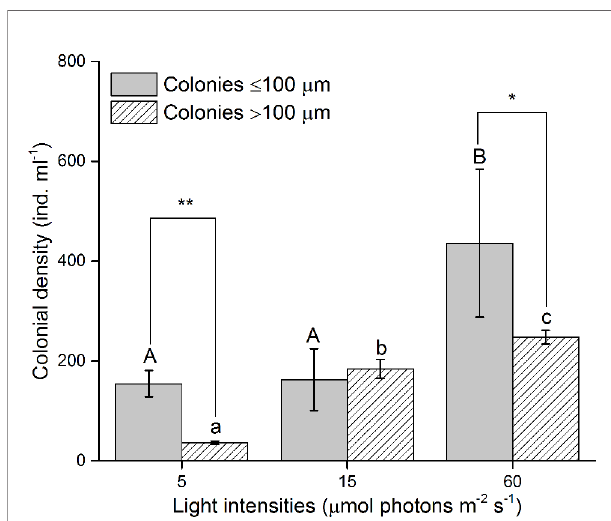
FIGURE 2 | Colonial density under different light intensities at the end of diploid cell culture experiments. * and **, signi fi cant difference (p < 0.05 and p < 0.01) between the density of ≤ 100 µm and > 100 µm colonies in the same light intensities. Different uppercase and lowercase letters indicate signi fi cant differences among the three light intensities for ≤ 100 µm and > 100 µm colonies,